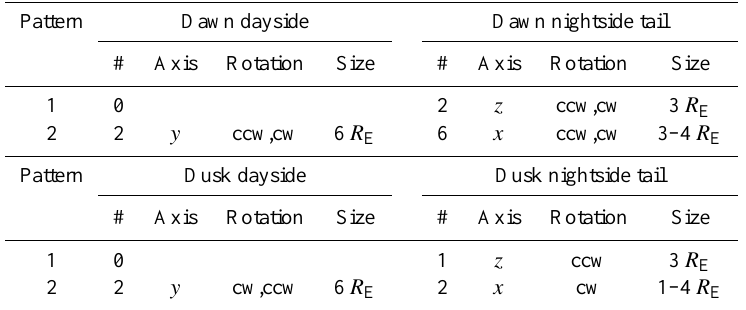
Fig. 7. Vortices on the dusk dayside. The vortices formed almost at the same x - y location, but with a different z coordinate. This is in the y = 7 R E cut plane. Table 3. Case 2: four quadrant vortex